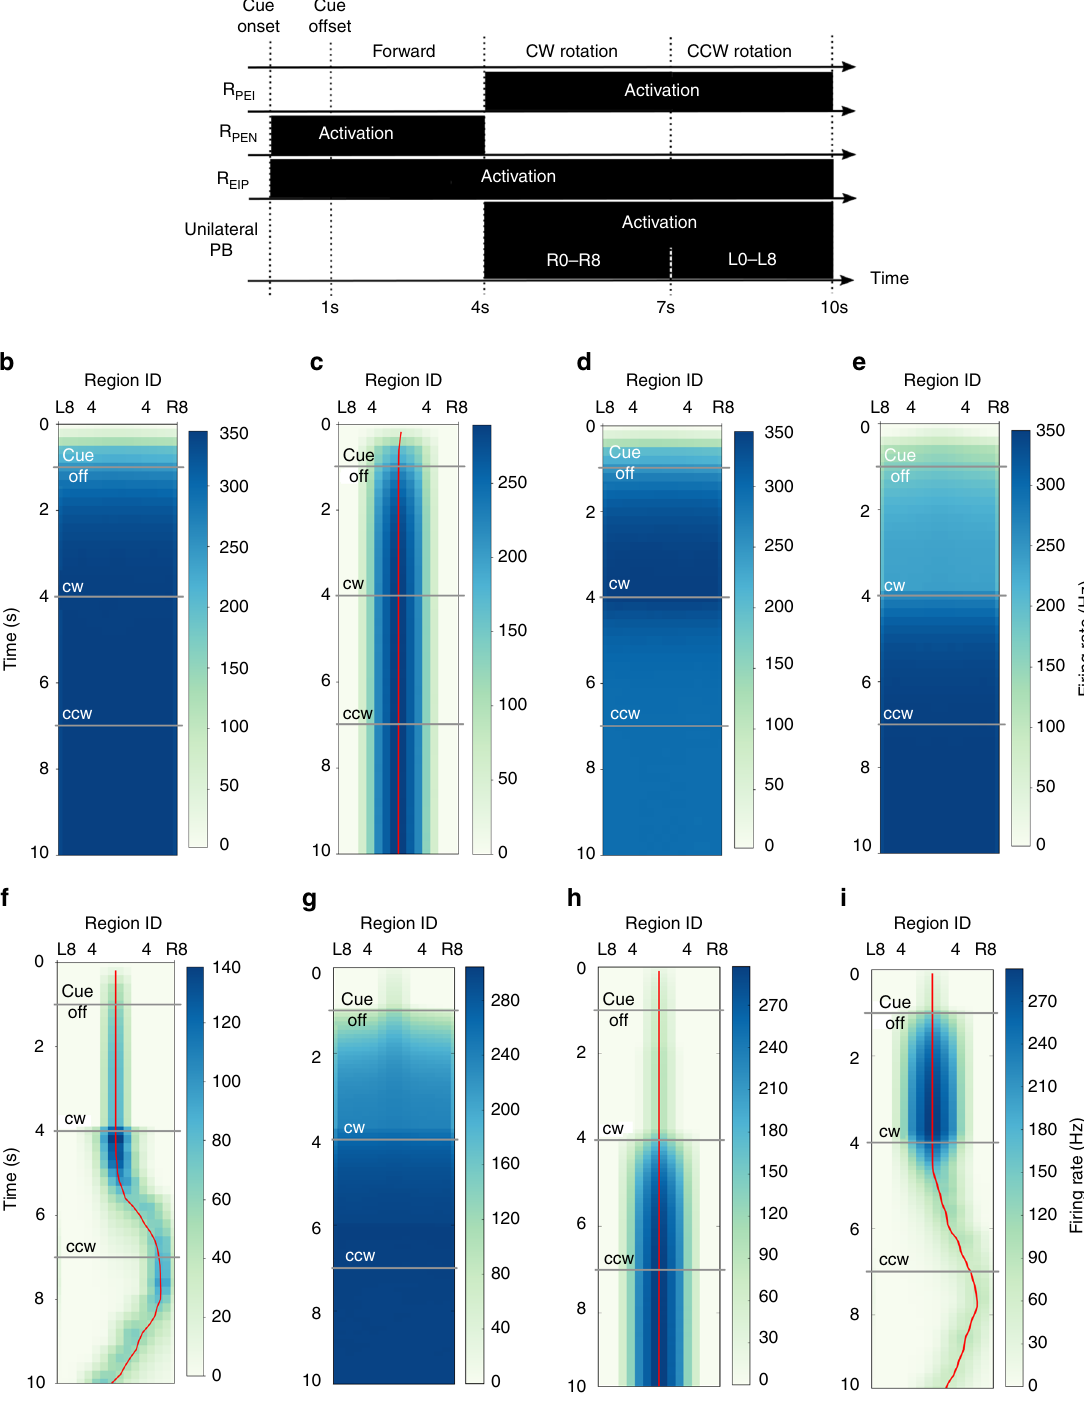
Fig. 5 Maintenance of spatial orientation memory requires coordinated operation of the ring neurons in the full EP – PB model. a The full model was tested using a task consisted of four periods in the following order: cue-onset, cue-offset/forward walking, clockwise, and counter clockwise body rotation. R PEN ring neurons activate (to inhibit the P-ring) during the cue-onset and cue-offset periods, while R PEI ring neurons activate (to inhibit the C-ring) during both rotation periods. R EIP needs to be activated throughout the entire period of the task in order to maintain the activity bump, while the unilateral PB input is responsible for shifting the bump during the rotation periods. We tested the functions of the ring neurons by including them one at a time and demonstrated the result in the region-based fi ring rate plots for the EB (as in Fig. 3a) with the following conditions: b no ring neuron, c with R EIP neurons only, d with R PEI neurons only and e with R PEN neurons only. We also tested the full model by taking out each ring-neuron type one at a time from the model with